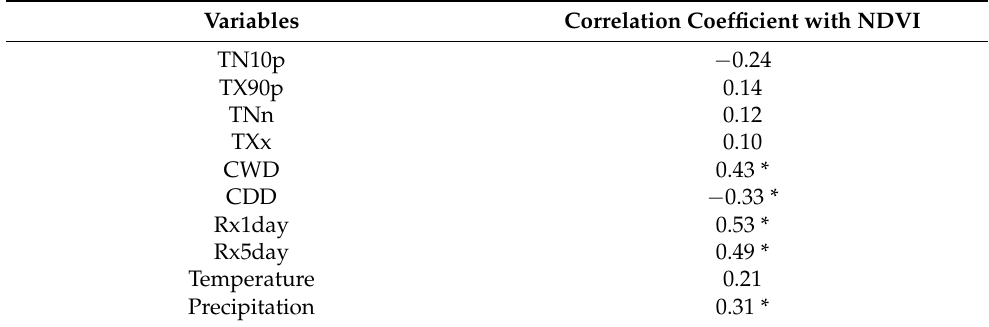
Table 2. Correlation coefficients of temperature and precipitation and related extreme indexes with